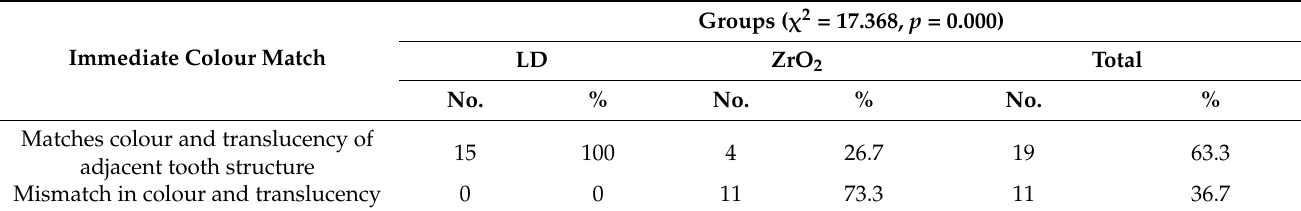
Table 9. The colour match in the study groups.